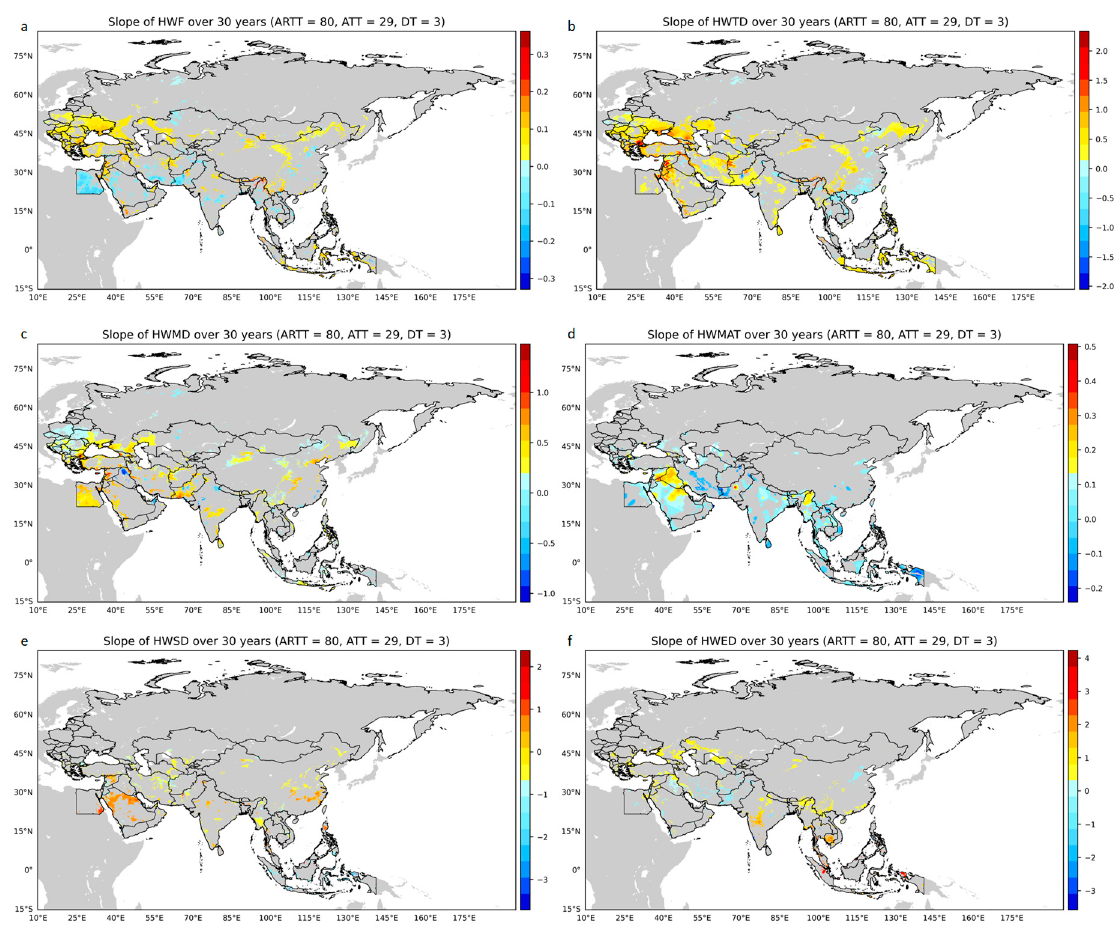
Figure 8. Slope over 30 years for: ( a ) HWF; ( b ) HWTD; ( c ) HWMD; ( d ) HWMAT; ( e ) HWSD; ( f ) HWED.